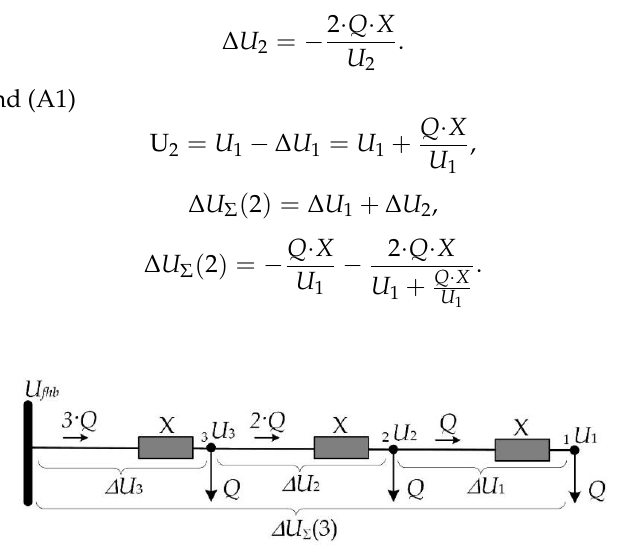
Figure A3. Equivalent circuit of the third term of (10).